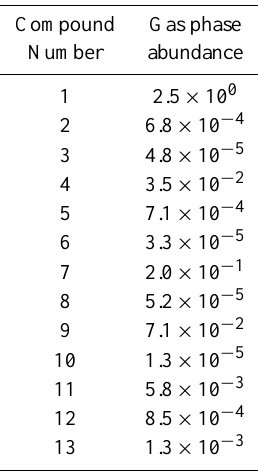
Table 5. Mixing ratios (ppt) of each compound used within the dynamical